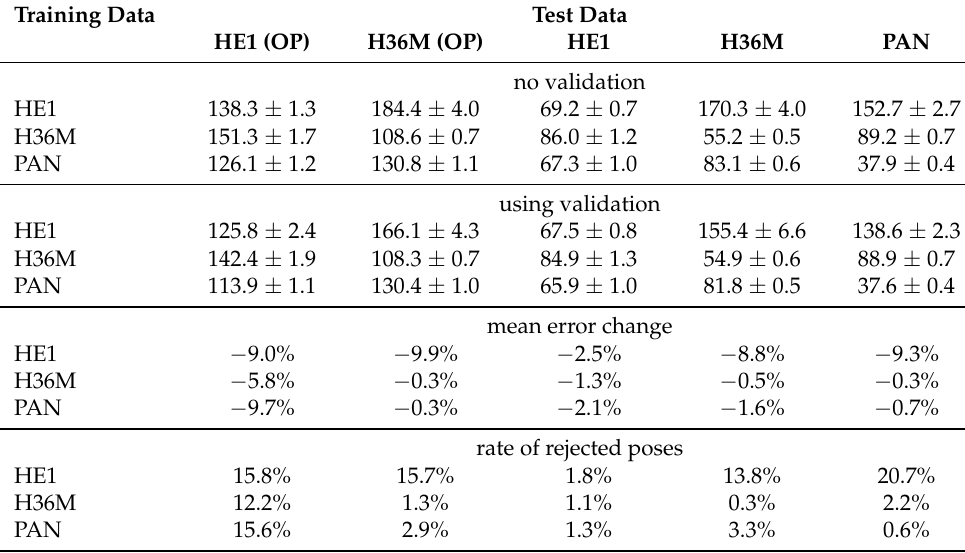
Table 14. Error with and without anatomical pose validation, with scale normalization (no-alignment errors in mm, mean ± std.